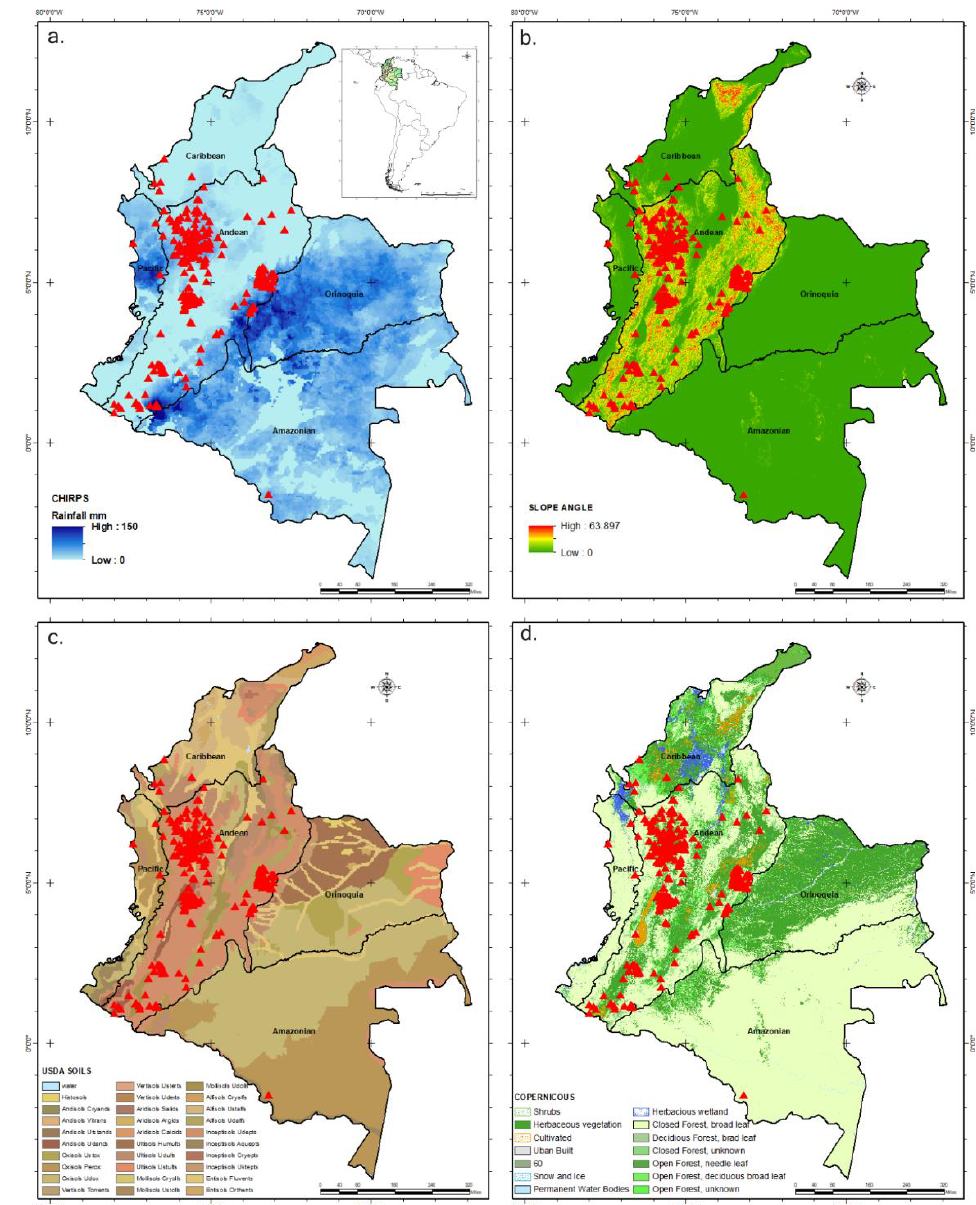
Figure 2. Datasets used for the study area and corresponding landslide events happening between 2016 and 2019: ( a ) CHIRPS rainfall (mm) — used in the logistic model and LTF method; ( b ) slope angle derived from SRTM V3 — used in the logistic model and LTF method. ( c ) USDA Soils Classification — used in the logistic model; ( d ) Copernicus Landcover 2019 — used in the logistic model.